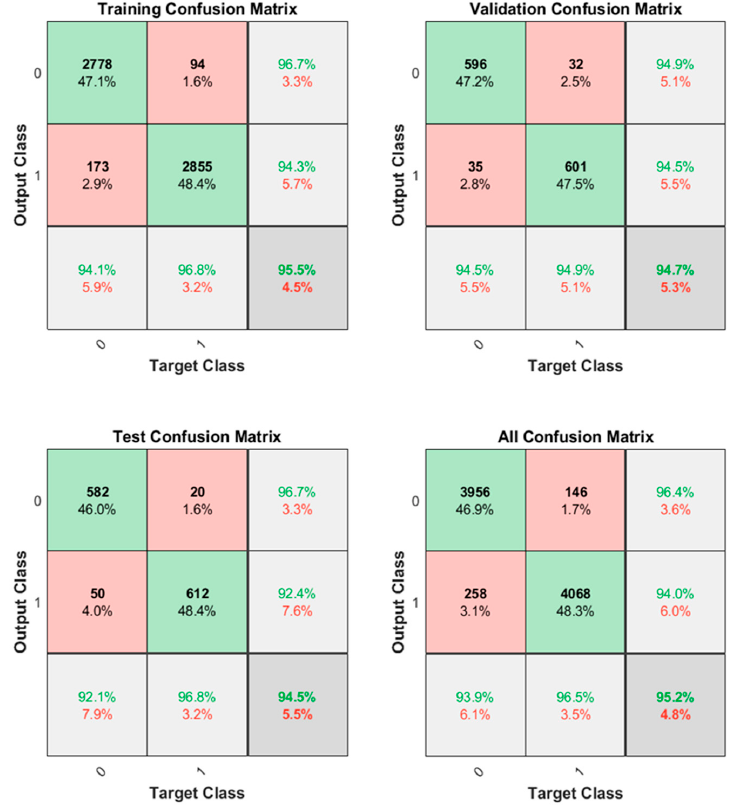
Figure 12. Confusion matrices for the tested scenario: drowsy driver (0) versus wakeful ones (1). Each of the confusion matrices report the performance of the proposed pipeline in discriminating drowsy/wakeful drivers for a selected subject from the collected dataset. For this subject-driver, the pipeline showed 94.5% of discrimination accuracy during the testing phase.